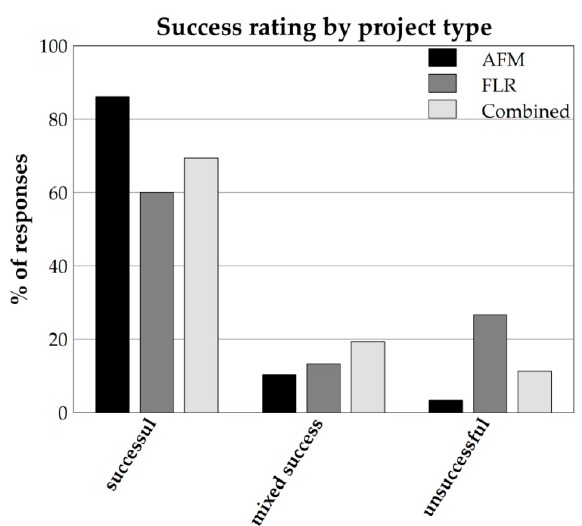
Figure 4. Ratings of project success by project type. Successful projects are defined as those where the respondents strongly agreed or mostly agreed that the implemented measures were successful in reaching the selected goals. Mixed success includes responses that partly agreed/disagreed with the mentioned statement. Unsuccessful cases are defined as those responses that mostly disagreed or strongly disagreed with the before ‐ mentioned statement.